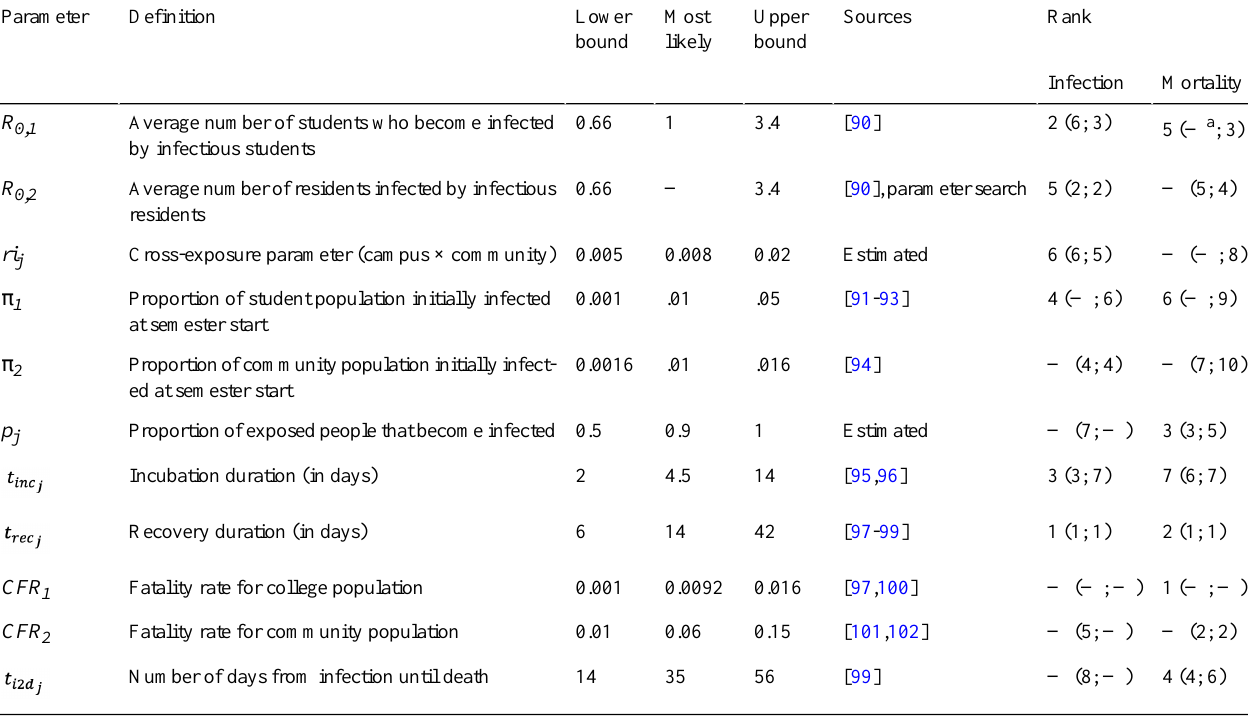
Table 1. Model parameters in the COVID-19 campus × community epidemic models, estimated values, literature sources, and ranges used for parameter search and sensitivity analysis. “Rank order” indicates the relative significance of each parameter on campus (community; additional community) outcomes (16-week totals); only statistically significant factors are shown ( α